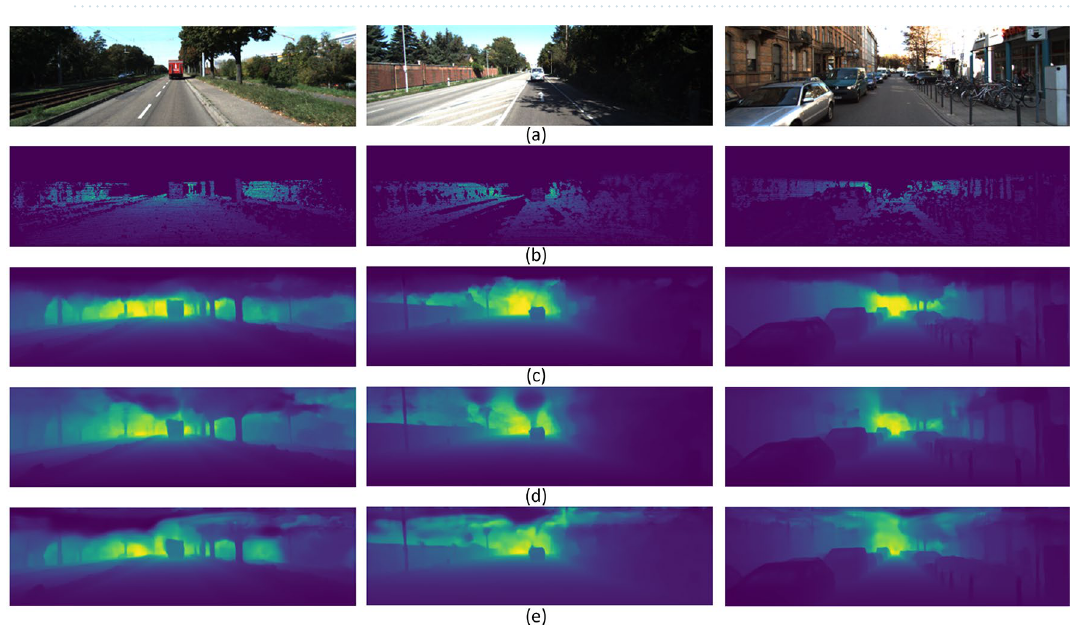
Figure 3. Qualitative evaluation of depth maps on NYU Depth v2 dataset. ( a ) input RGB images; ( b ) ground- truth depth maps; depth maps predicted by ( c ) Bhat et al. 14 , ( d ) Ranftl et al. 3 , and ( e ) proposed model.